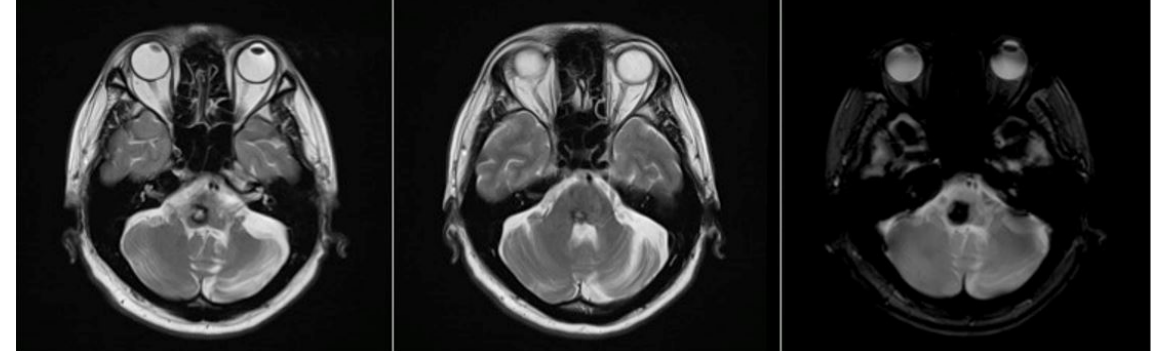
Figure 3: T2-weighted images from the patient’s cranial magnetic resonance imaging